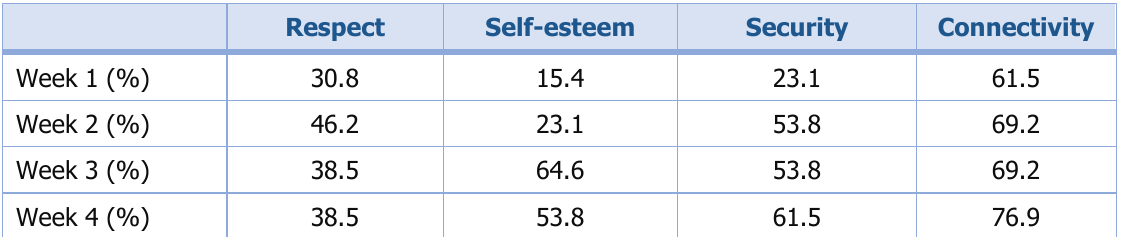
Table 6. Percentages of Weekly Emotional Safety Qualitative Responses for Equine Assisted Learning At-Risk Youth